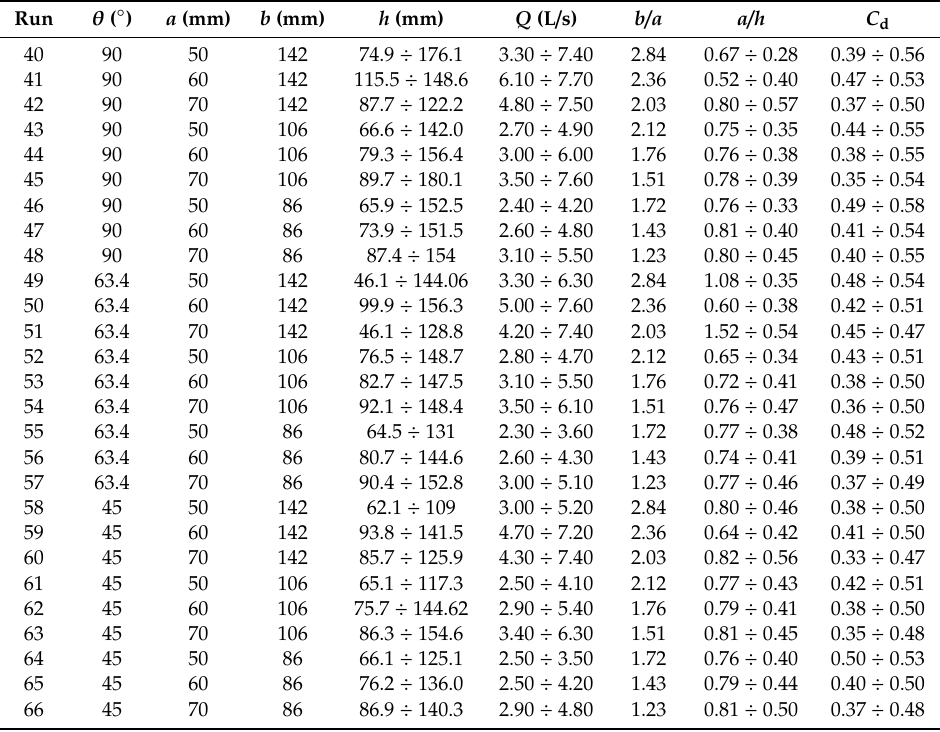
Table 3. Experimental data Series 3 (see also